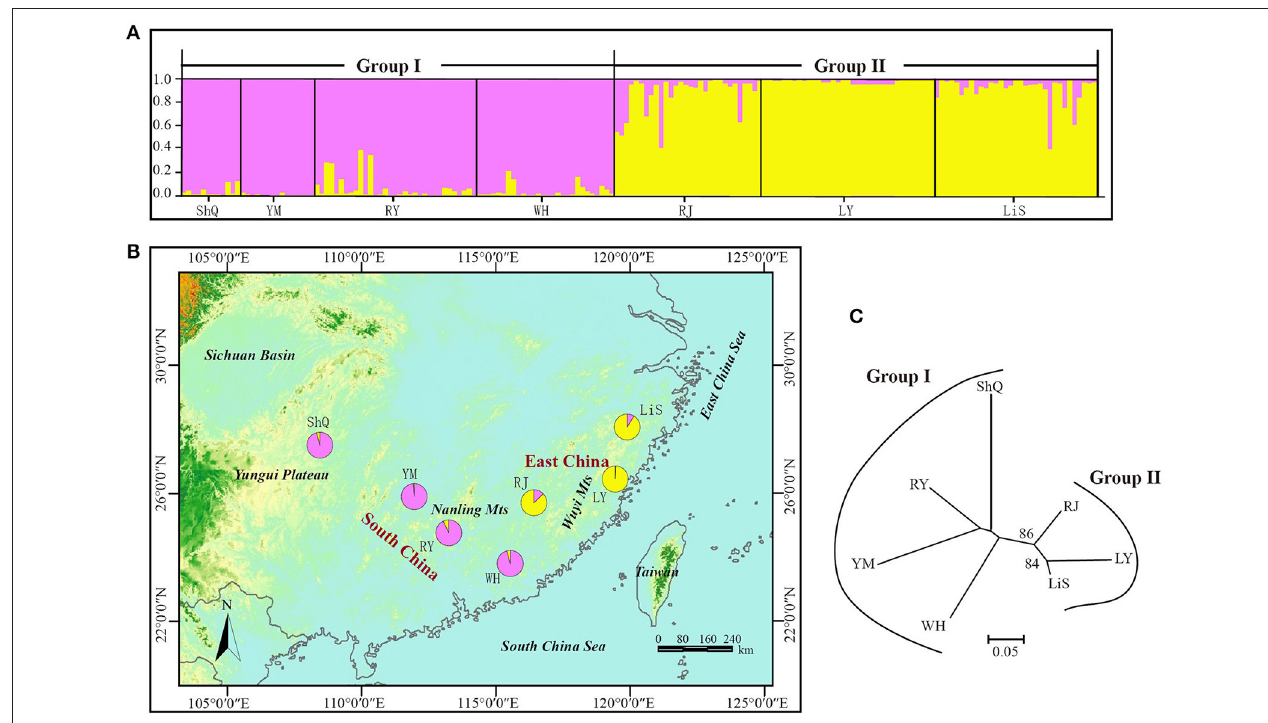
FIGURE 5 | NJ tree and Bayesian clustering analysis results for 14 EST-SSRs of 186 individuals (7 populations) of Actinidia eriantha from South China and East China. (A) Histogram of the STRUCTURE analysis for the model with K = 2 (showing the highest delta K). Each individual is represented by a single vertical line. On the y-axes is the likelihood of assignment to each cluster. (B) Geographic origin of the seven populations and their color-coded grouping according to the STRUCTURE analysis. Population codes are identified in Table 1 . (C) The neighbor joining tree of the seven populations with bootstrap values indicated in nodes with support ( > 50).